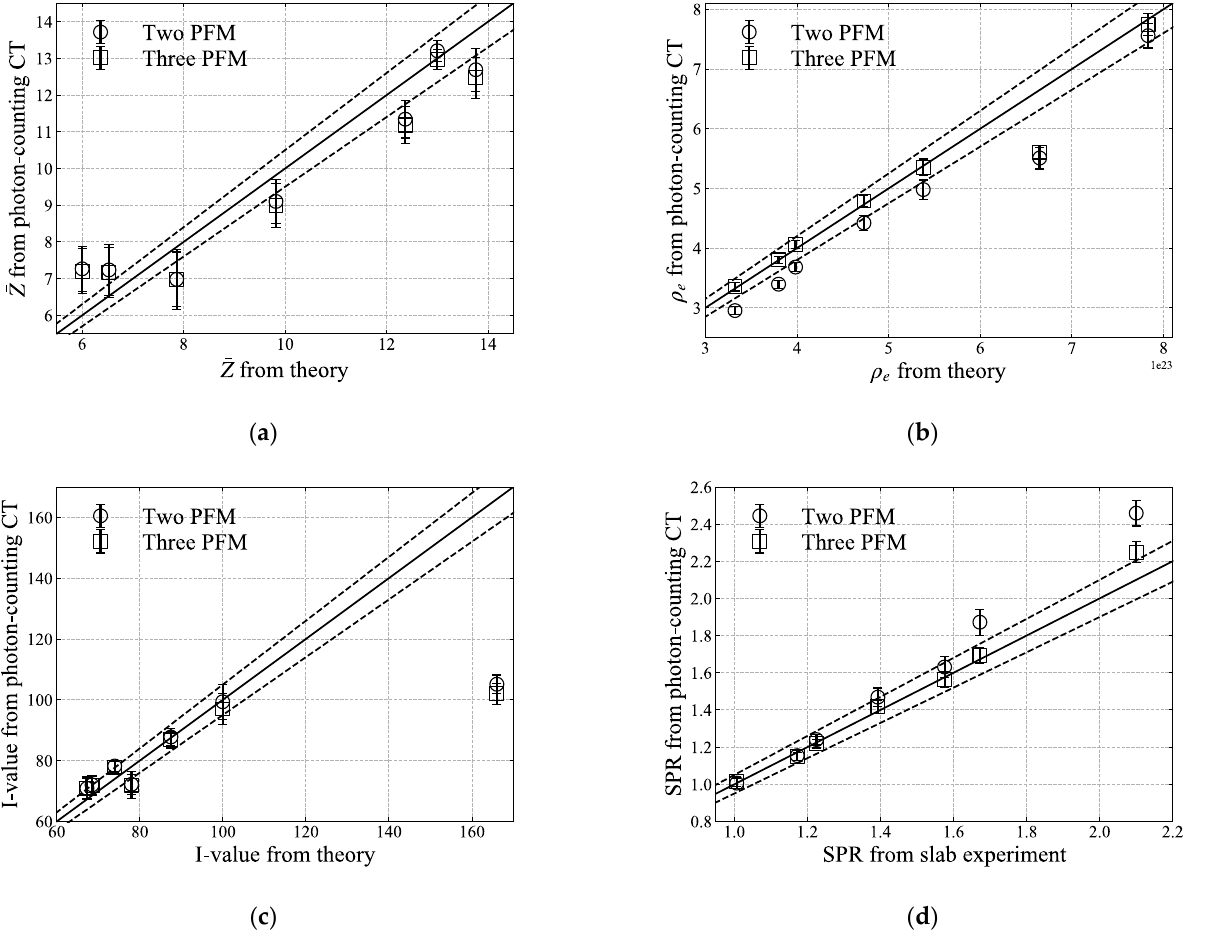
Sensors 2021 , 21 , x FOR PEER REVIEW Figure 10. Maps calculated via three-PFM for ( a ) effective atomic number, ( b ) electron density, ( c ) I -value, and ( d ) SPR. The I -values were parameterised using the fitting curve of the mixture in Figure 4, calculated using the Bragg additivity rule.